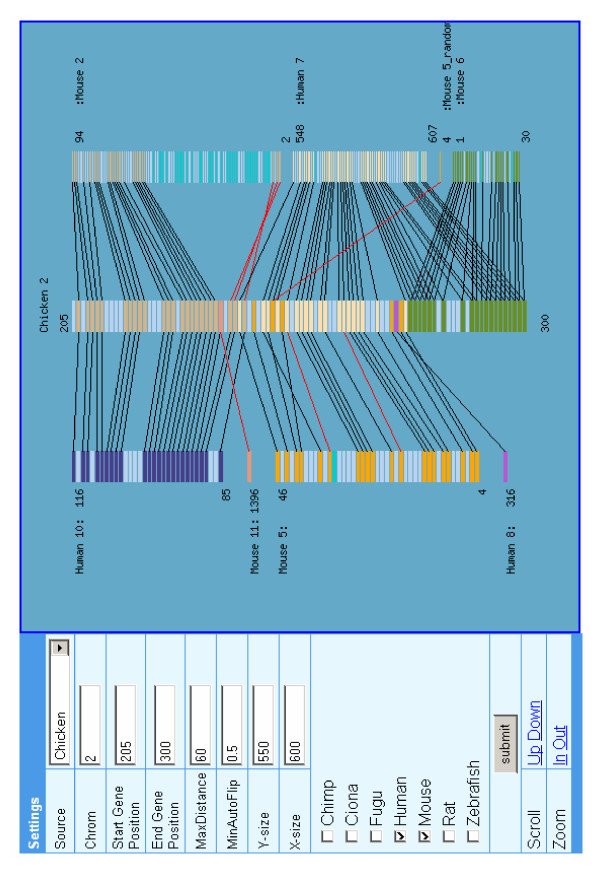
An example Synteny Map. Genes ranging from number 205 through 301 on chicken chromosome 2 (numbered as they occur from the p-telomere to q-telomere along the chromosome) are shown as rectangles in the center of the diagram. On the left and right are the orthologs of these genes found in the human and mouse genomes as determined by the PhIGs analysis, shown as they are arranged. Black connecting lines join orthologs in the same relative transcriptional orientation whereas red lines indicate those that are inverted. Blue rectangles indicate intervening genes without identified orthologs in the genomes being compared. Cyan rectangles that do not have connecting lines, as can be seen for a portion of mouse chromosome 2, indicate that orthologs exist in chicken (the query genome), but not in the portion specified for this page.